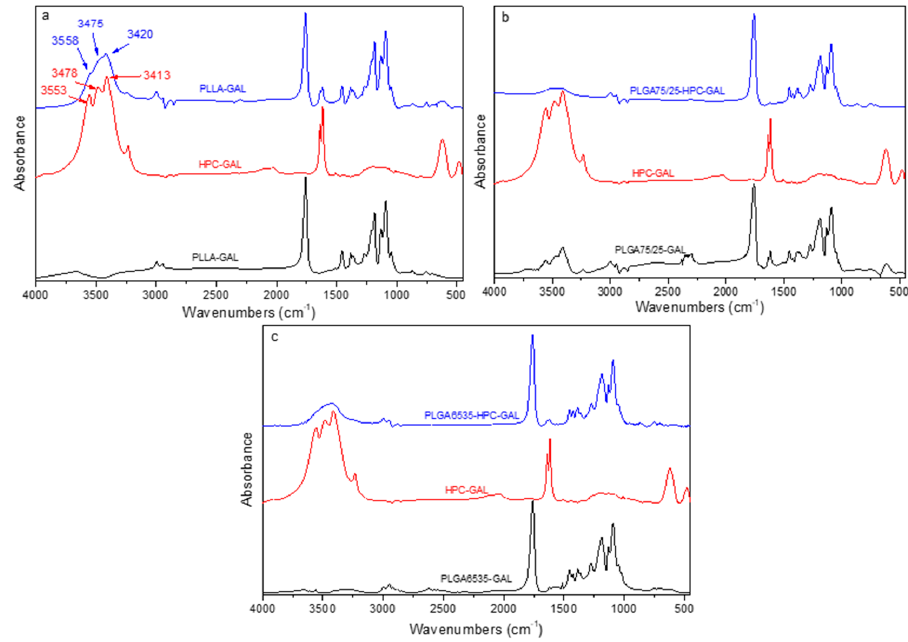
Figure 7. FT-IR spectra of nanoparticles with HPC–GAL. ( a ) PLLA–HPC–GAL, ( b ) PLGA 75/25–HPC–GAL, and ( c ) PLGA 65/35–HPC–GAL. Pharmaceutics 2020 , 12 , 227